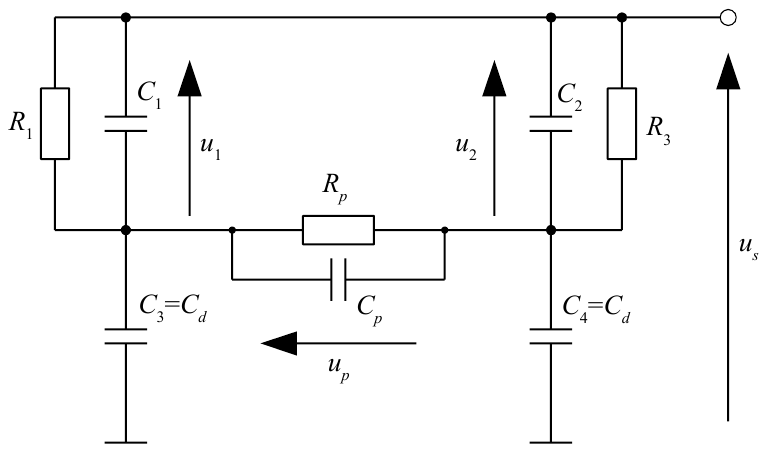
Figure 2. Schematic diagram of a circuit including loads created by inputs of the data acquisition system. Elements R p and C p are present only in case